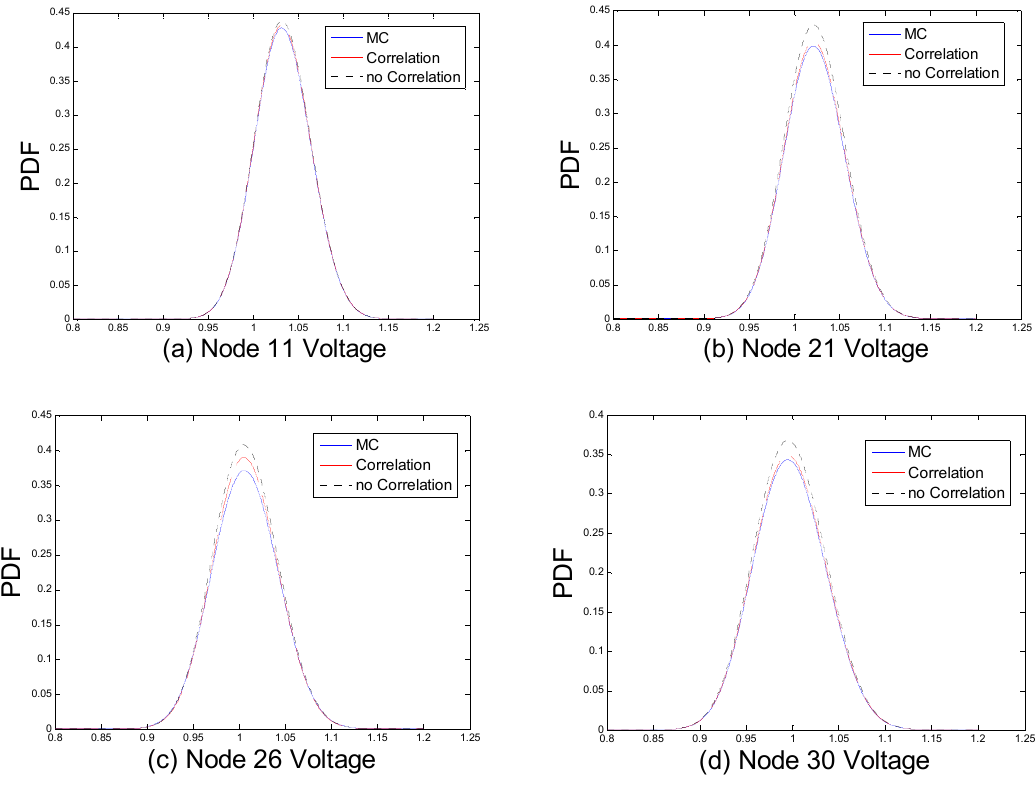
Figure 10. PDFs of node voltage. Table 6. Deviation estimation indicators with/without correlation.